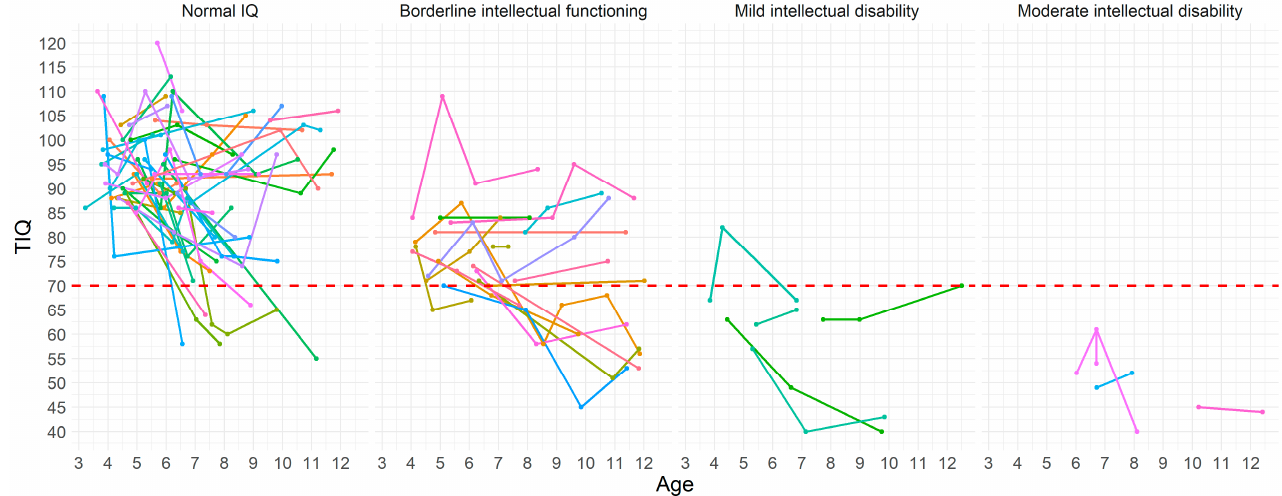
Figure 3. Individual IQ changes in patients with normal IQ, borderline intellectual functioning, mild intellectual disability, and moderate intellectual disability. Key to figure: dashed red line TIQ = 70, each colored line represent an individual patient.